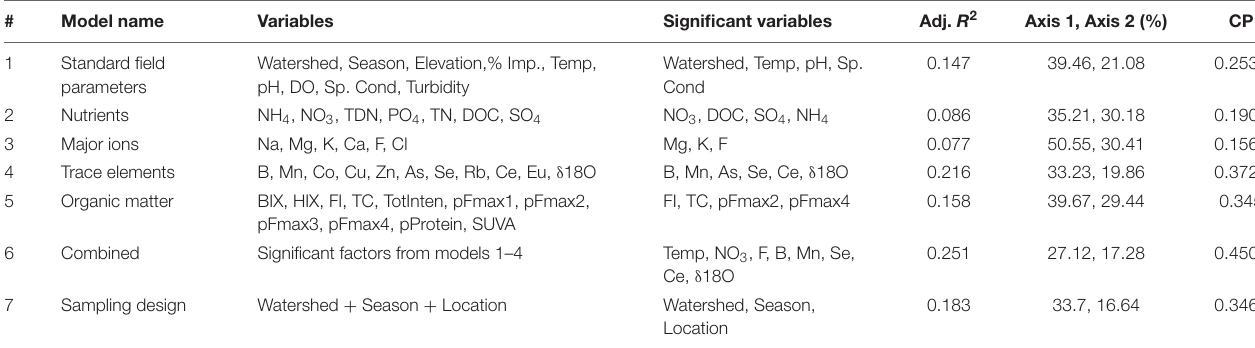
TABLE 3 | Redundancy analysis (RDA) model results indicating the stream physiochemical variables structuring bacterial communities in streams across three watersheds (Logan, Red Butte, and Provo) and three seasons (Fall, Winter, and Spring).